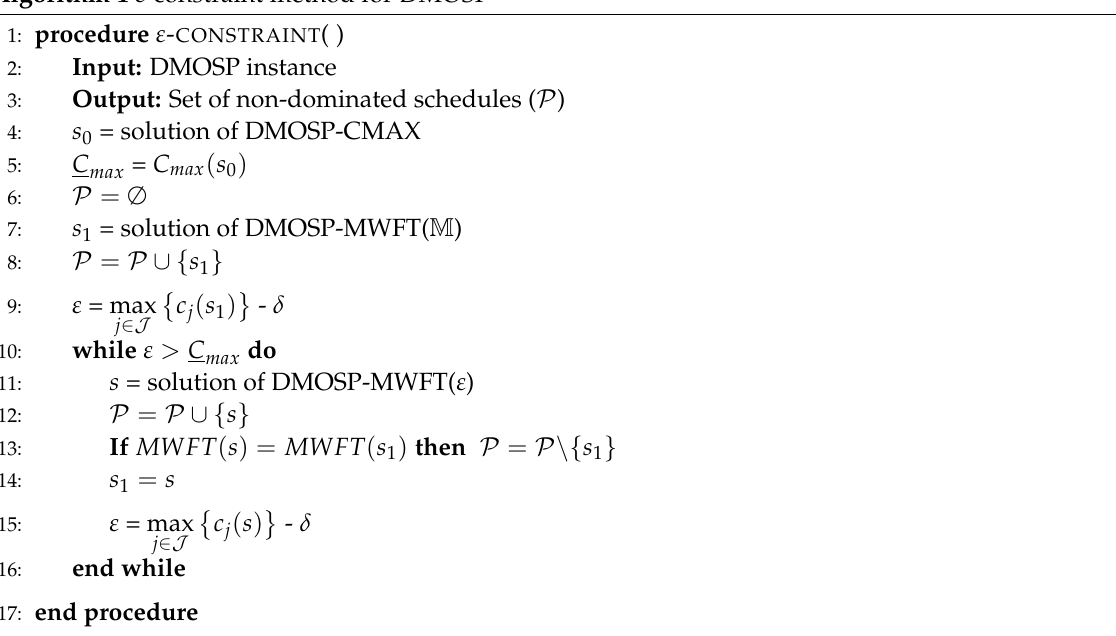
Algorithm 1 ε -constraint method for